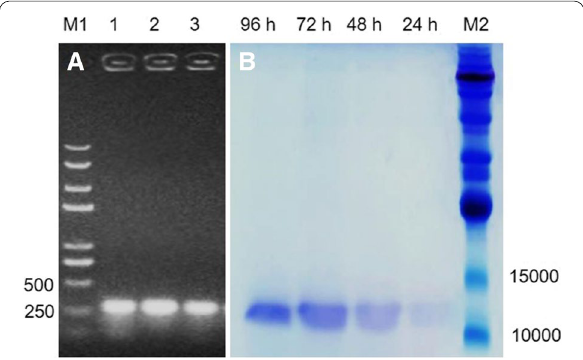
Fig. 3 Detection of transformants by PCR ( A ) and an analysis of expressed proteins by SDS‑PAGE ( B ). In panel A M1: DNA marker (D8000), 1 3: PCR analysis of transformants carrying the esxA ; in − panel B 24, 48, 72, and 96 h: induction periods; M2: protein marker (P0060). DNA (bp) and ptoerin lanes (Da) labelled with molecular